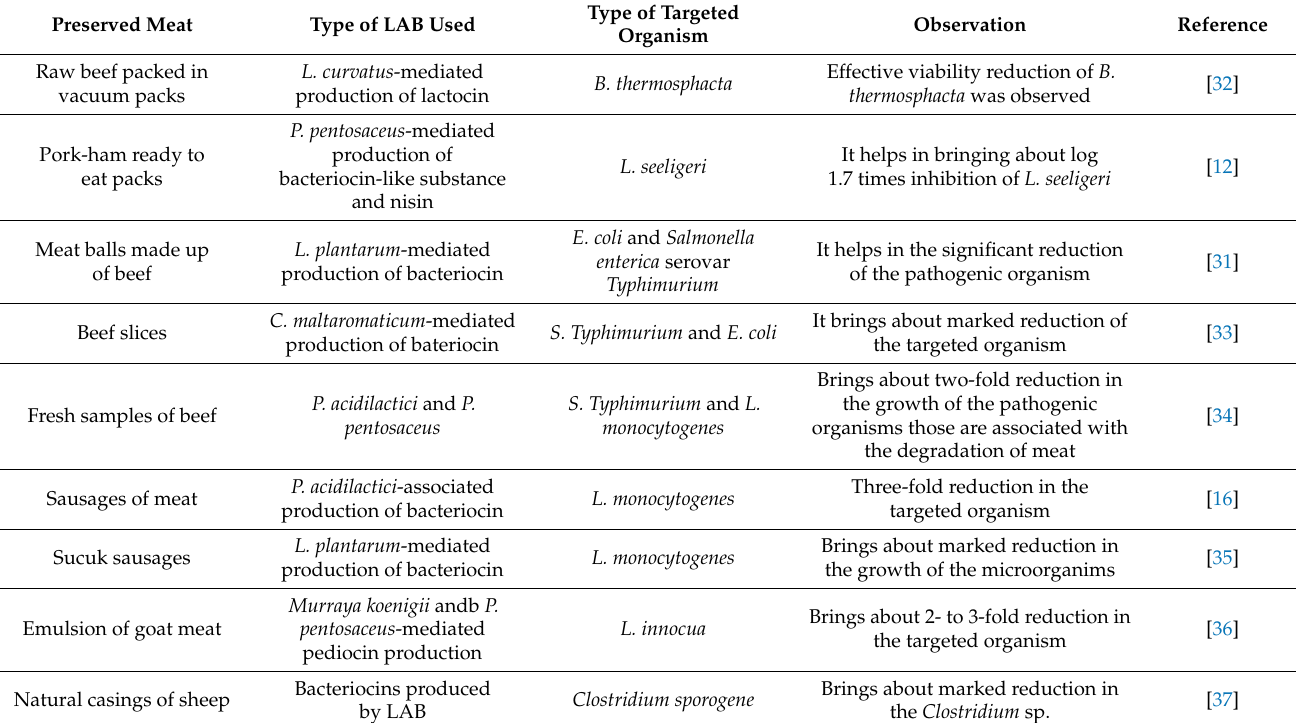
Table 2. LAB-associated protection of various types of packaged meat and meat